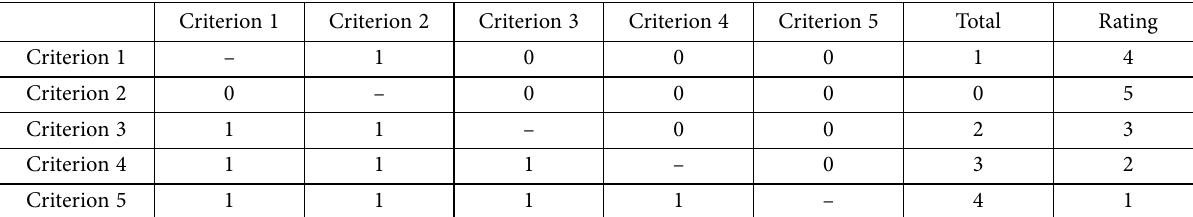
Table 1. Preference matrix through swing rating method (adopted from Gonçalves et al., 2019)